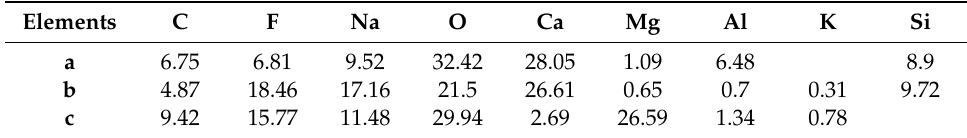
Figure 5. SEM-EDS analysis of the final product. Micro area ( a ) shows conversion reaction of fluoride; micro area ( b ) shows complete conversion of fluoride; micro area ( c ) shows dolomite decomposition. (1) EDS analysis of different positions of the final product (wt%).